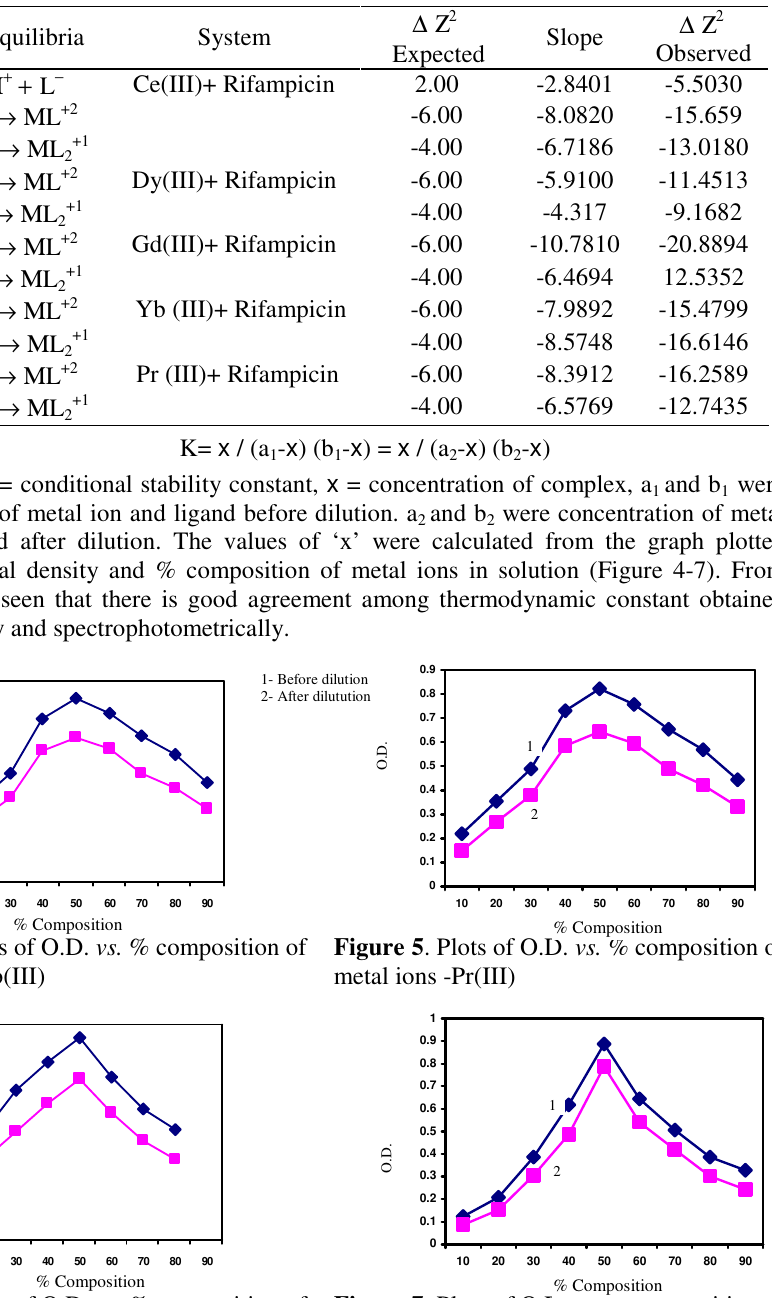
Table 3. Values of ∆ Ζ 2 determined from the plots of pK vs. µ